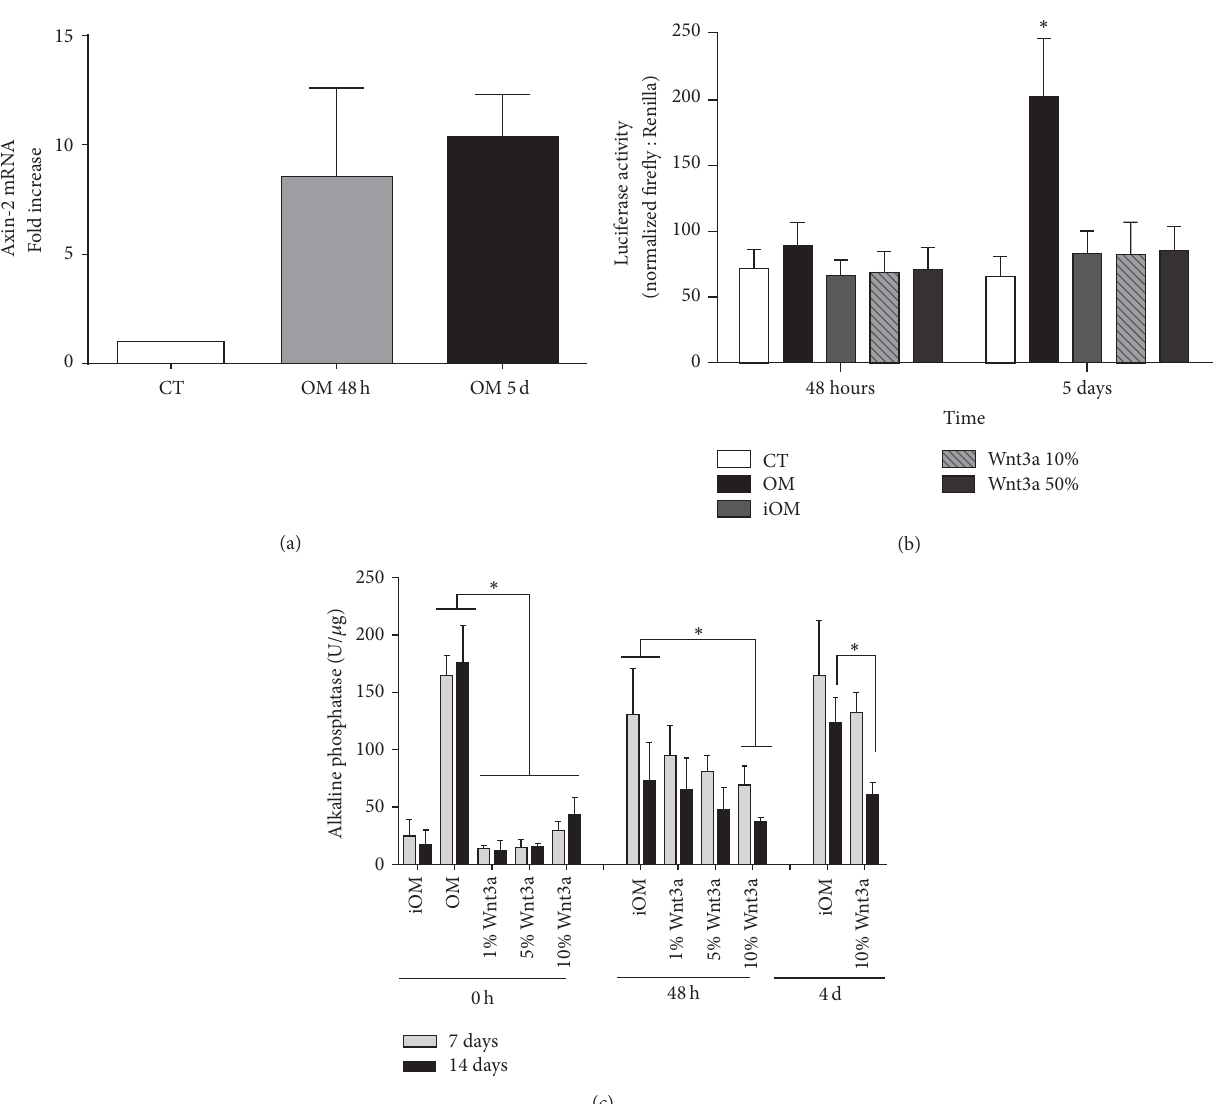
Figure 1: Osteogenic medium, but not Wnt3a-CM, induces 𝛽 -catenin signaling and BMSCs osteogenic differentiation. (a) BMSCs were cultured in osteogenic medium (OM) for 48 h and 5 days and Axin-2 mRNA fold increase was evaluated. Bars represent mean ± SD of 3 independent experiments performed in triplicate. (b) Luciferase activity in BMSCs containing a SuperTop TCF reporter, osteoinduced for 48 h and 5 days with incomplete osteogenic medium (iOM, without dexamethasone), osteogenic medium (OM), or iOM containing 10% or 50% Wnt3a-CM. CT = undifferentiated cells. Bars represent mean ± SD of 4 experiments performed in triplicate. (c) Alkaline phosphatase activity in BMSC cultures after 7 and 14 days of osteoinduction with OM or iOM containing 1%, 5%, and 10% Wnt3a-CM. iOM supplemented with Wnt3a-CM was added at the onset of induction (0h) or after 48 h and 4 days of osteoinduction with OM. Mean ± SD of 5 independent experiments with triplicates is shown. ∗ 𝑝 < 0.05